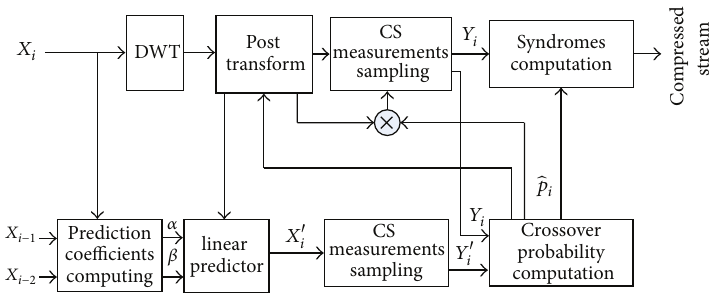
Figure 4: Proposed deep coupling coding among PT, CS, and DSC.